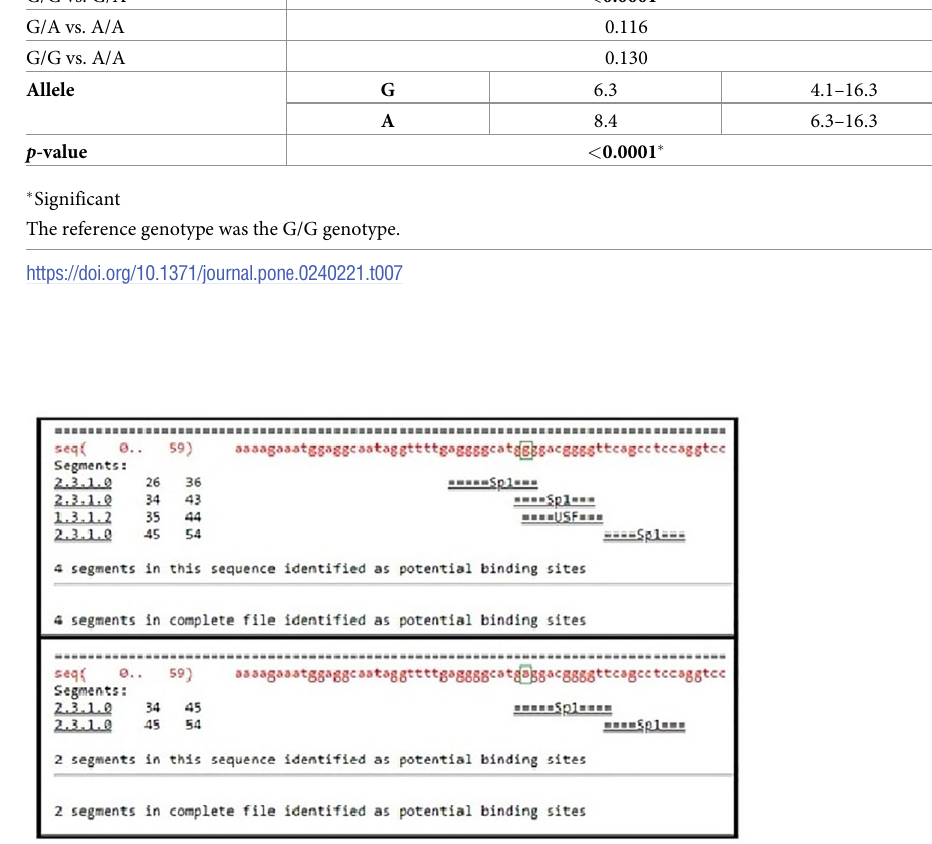
Fig 2. Using Alibaba software, transcription factors binding sites in the normal TNF- α gene sequence were found to be four, three binding sites for specificity protein 1 (SP1) transcription factor and one binding site for upstream transcription factor (USF) transcription factor; while in the mutant sequence, due to the tumor necrosis factor (TNF)- α -308 G/A gene polymorphism (rs1800629), there were two SP1 transcription factor binding